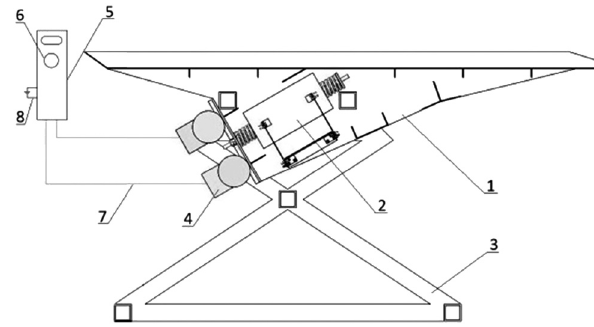
Figure 10: Scheme of how the machine is controlled: 1 – trough, 2 – eliminator, 3 – supporting frame, 4 – electrovibrators, 5 – vari - able - frequency drive, 6 – frequency tuning dial, 7 – four - core elec - trical wire, 8 – DC voltage source 230 V/50